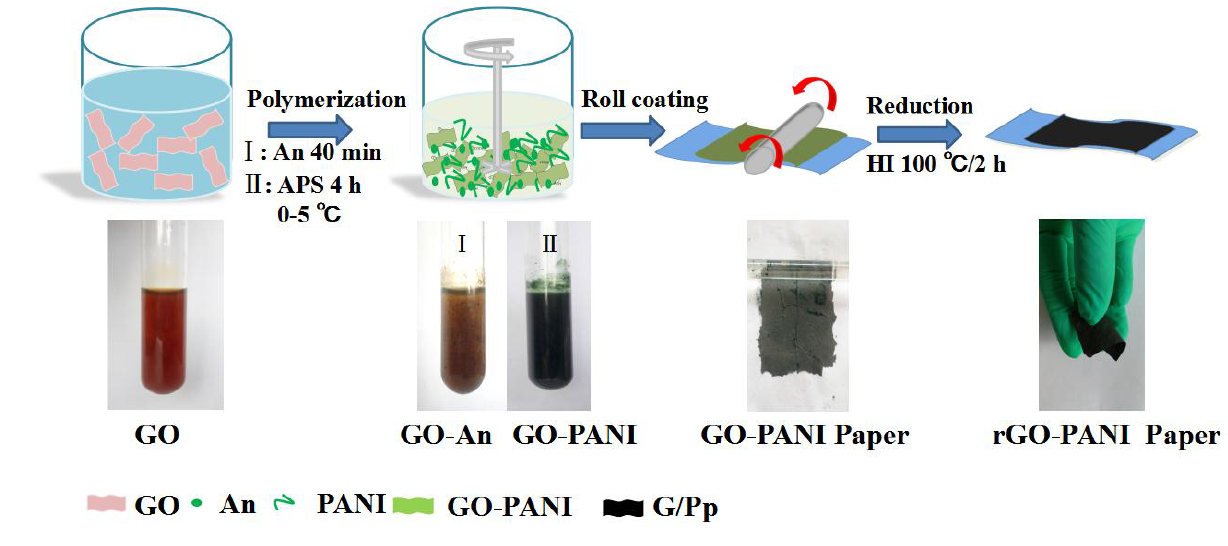
Figure 12: Preparation process of GPp